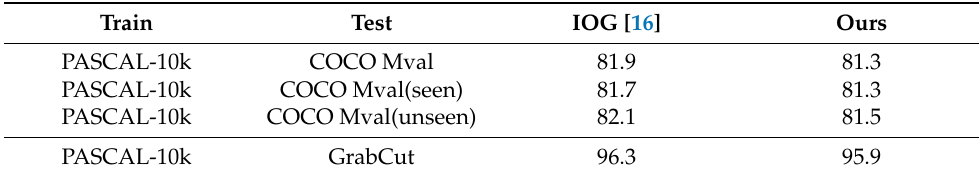
Table 3. The generalization ability of our proposed IPL-Net.